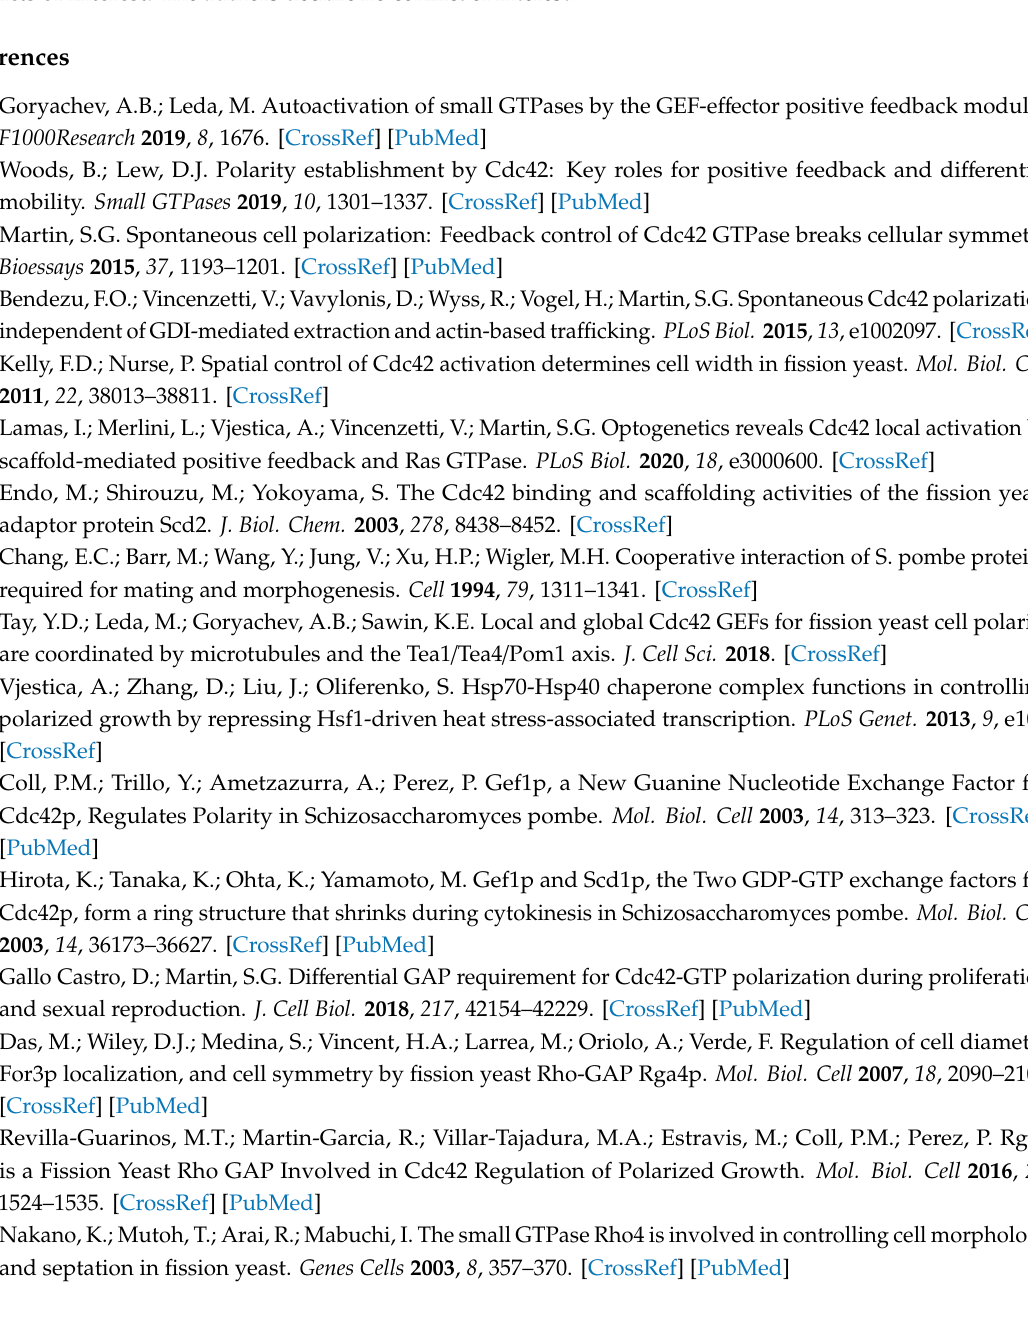
of Cdc42, Figure S5: Control and single-cell traces for optogenetic recruitment in scd1 ∆ and gef1 ∆ cells, Figure S6: Control and single-cell traces for optogenetic recruitment of Scd1-3GFP and CRIB-3GFP in WT and sdc2 ∆ cells, Figure S7: Additional examples for CRY2-Cdc42 ∆ CaaX induced Scd1-3GFP cell side recruitment, Figure S8: Control and single-cell traces for optogenetic recruitment of CRIB-3GFP and Pak1-sfGFP in rga4 ∆ rga6 ∆ cells, Table S1: List of strains used in this